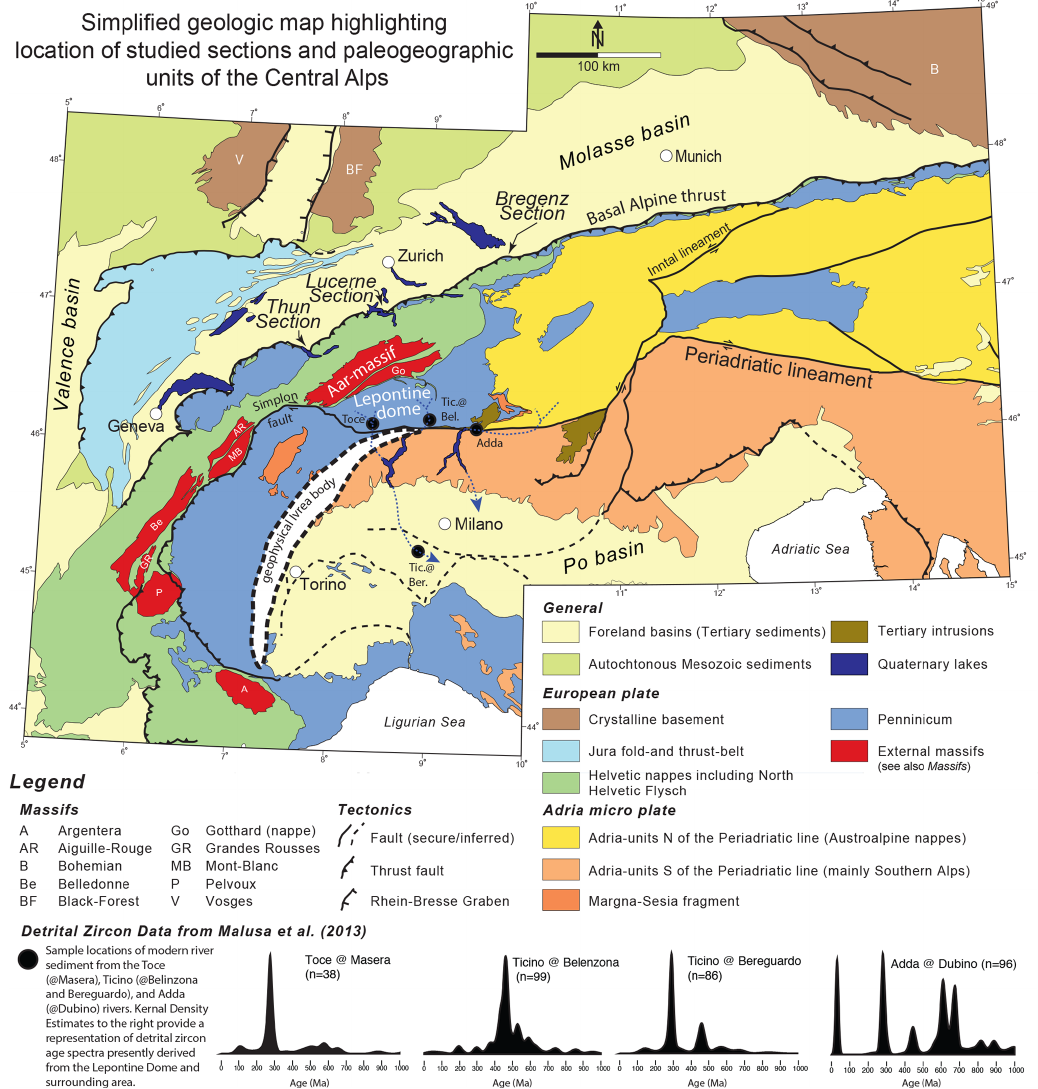
Figure 1. Geologic map of the Central Alps and Swiss Molasse Basin highlighting geologic features and paleogeographic units discussed in the text (map is adapted from Garefalakis and Schlunegger, 2019, and based on Froitzheim et al., 1996, Schmid et al., 2004, Handy et al., 2010, and Kissling and Schlunegger, 2018). Locations are shown for the Lucerne Section, Thun Section, and Bregenz Section, which are highlighted in Fig. 3a, b, and c, respectively. Kernel density estimates (KDEs; bandwidth set to 10) of detrital zircon U–Pb age data from modern river samples (Malusà et al., 2013) represent potential age spectra of currently exposed units within and surrounding the Lepontine